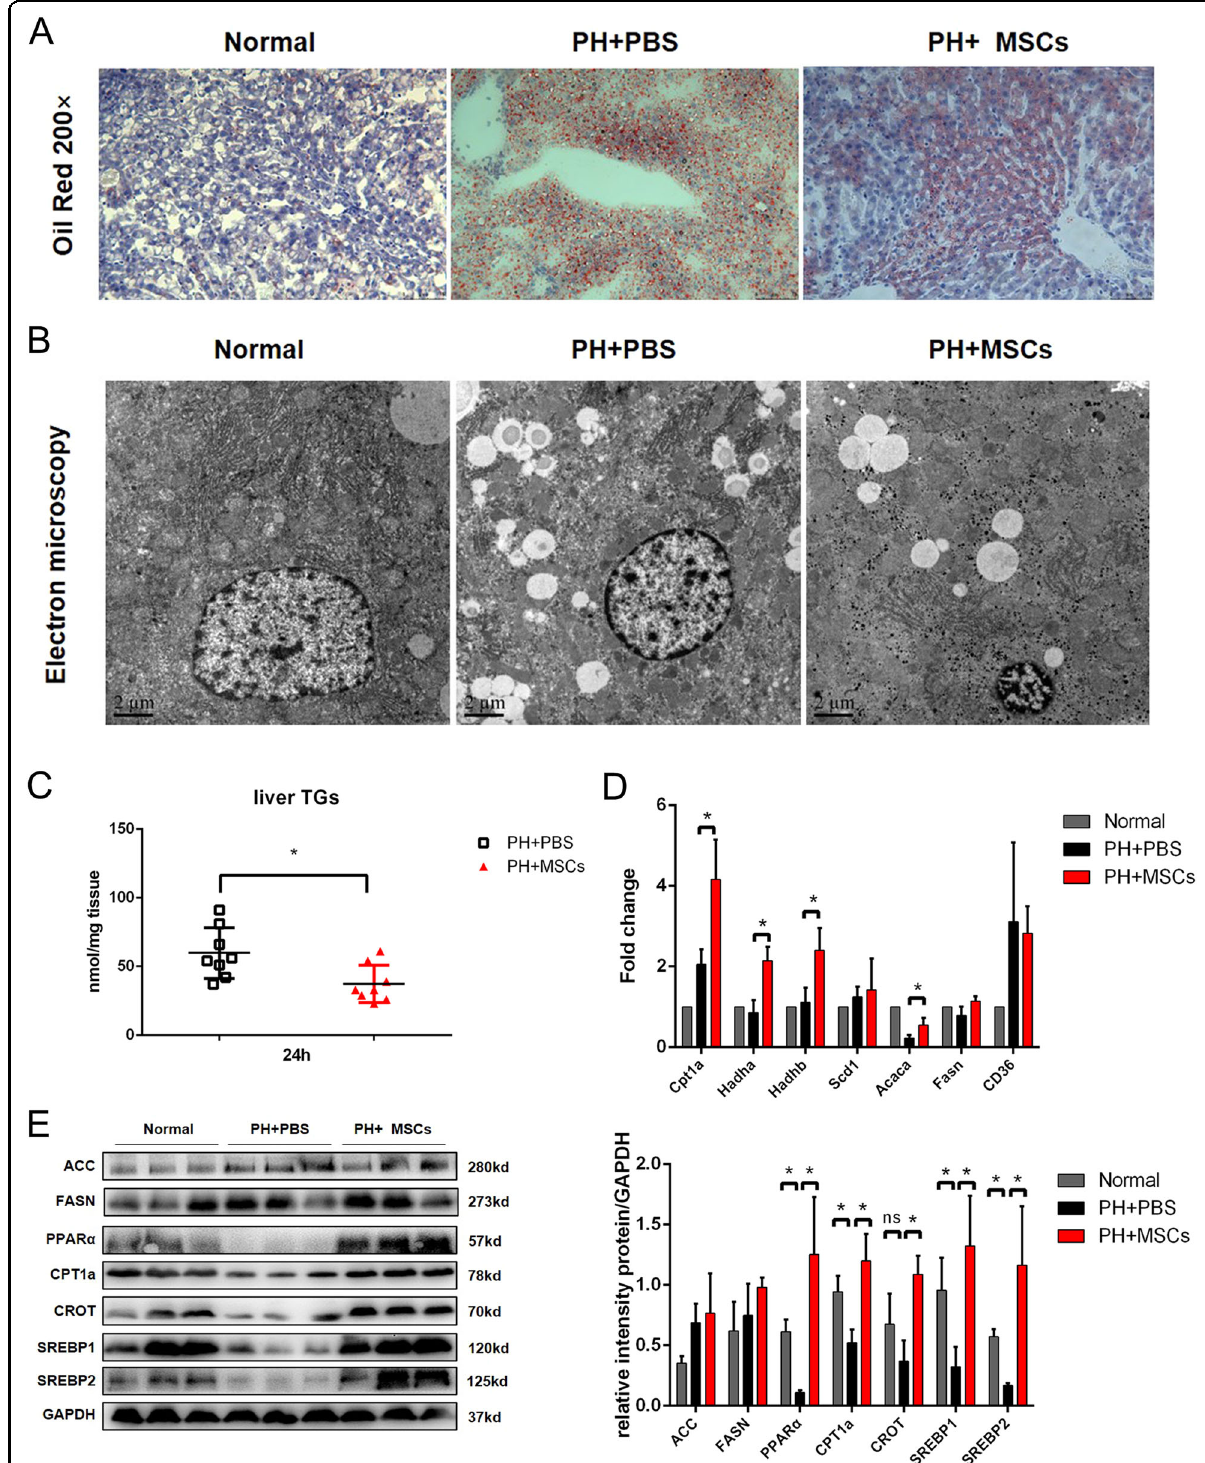
Fig. 2 MSCs transplantation reduces lipid accumulation after hepatectomy. A Oil red staining of liver tissue. B Electron microscopy of liver tissue. C Detection of TG content in liver tissue. D , E Western blotting analysis and RT-PCR of liver lipid metabolism-related genes and proteins. * P < 0.05. t -test, data are shown as mean standard